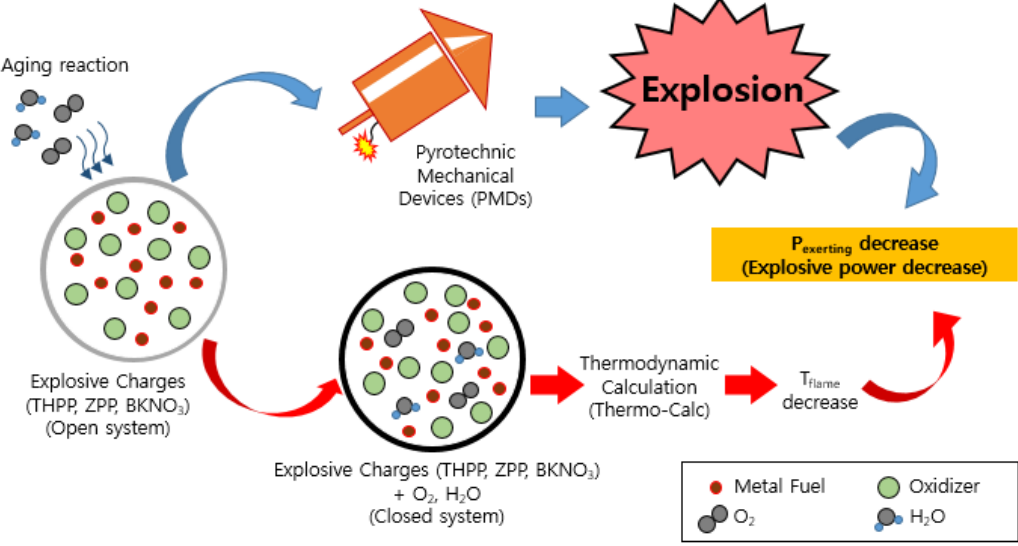
Figure 1. Schematic representation of the thermodynamic analysis of the aging of explosive charges.